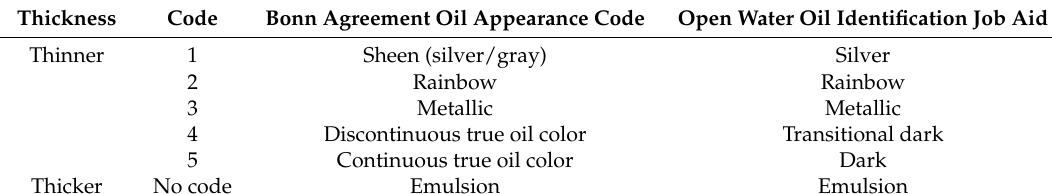
Table 1. Two methods to code oil slick thickness.